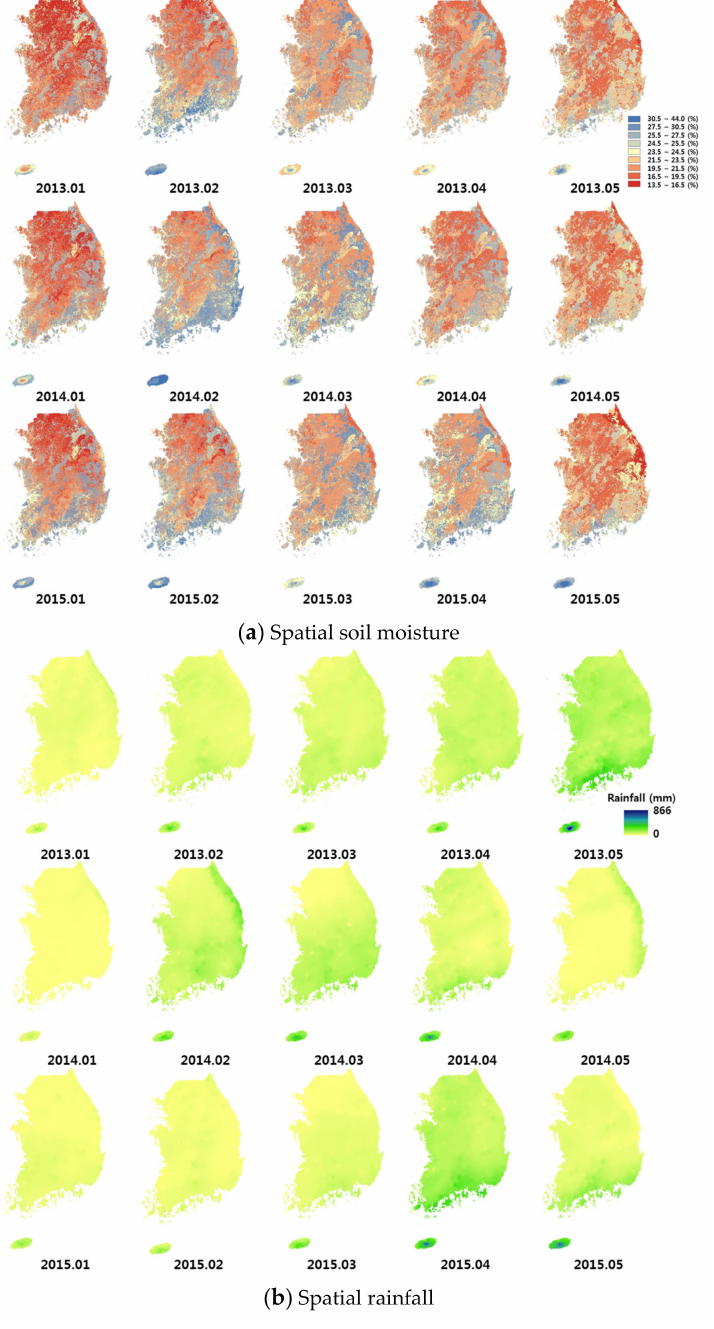
Figure 9. Spatial comparison of monthly (2013–2015) ( a ) soil moisture and ( b ) rainfall throughout South